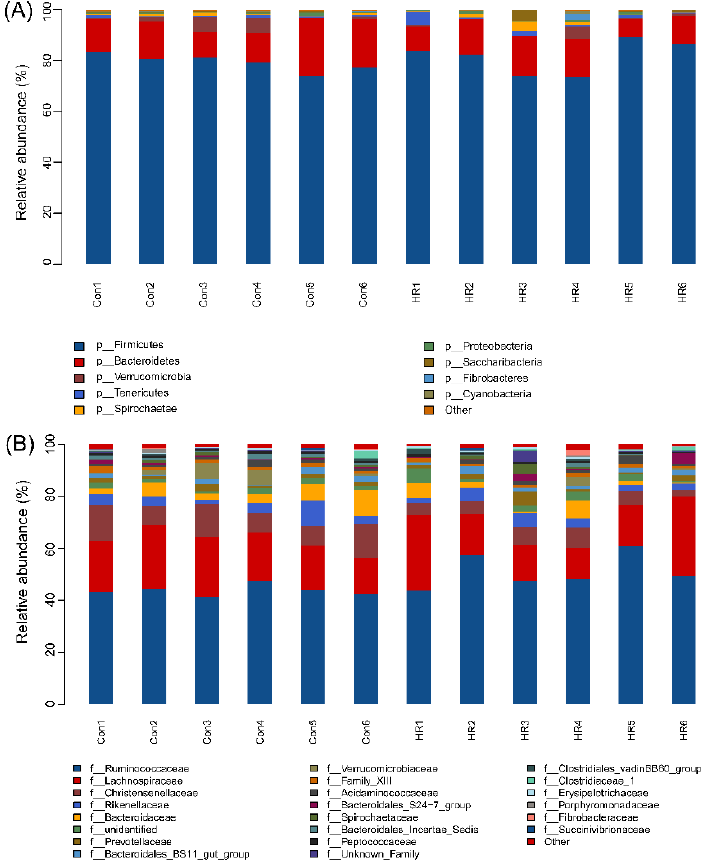
Figure 5. The intestinal bacterial community structure of the goats. ( A ) Distribution of colonic bacteria at the phylum level between dietary treatments in goats. ( B ) Distribution of the colonic bacteria at the family level between dietary treatments in goats. Con1–Con6 and HR1–HR6 are the colonic samples of goats fed with 55% or 90% concentrate, respectively.